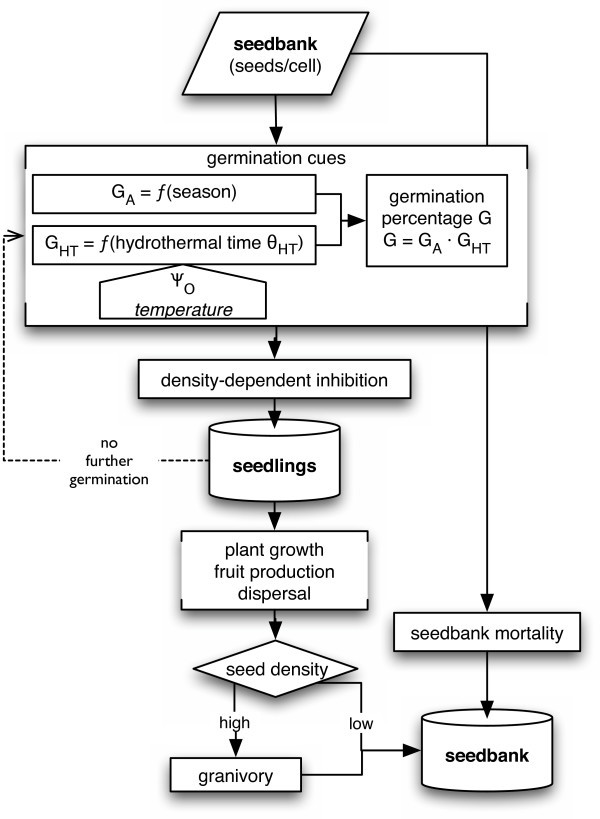
Flow chart of the seed bank module. GA: 'activity' (inverse of dormancy), GHT: 'hydrothermal' germinability (inverse of quiescence), ΨO: soil water potential at 0–1 cm depth.